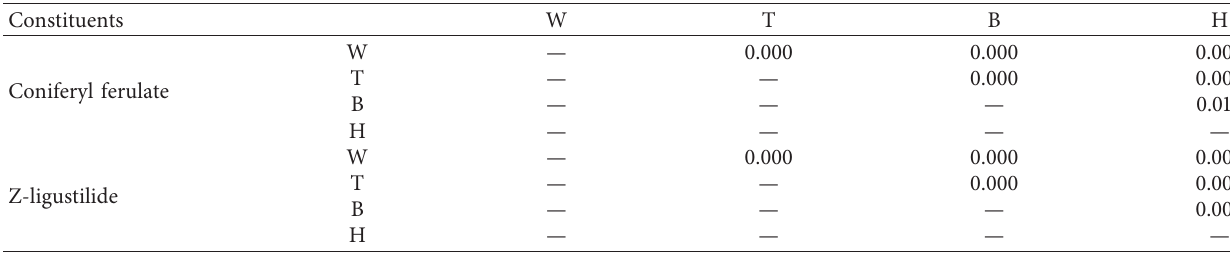
Figure 4: The comparison of difference markers among DG and different parts. Table 6: The P results of LSD of one-way